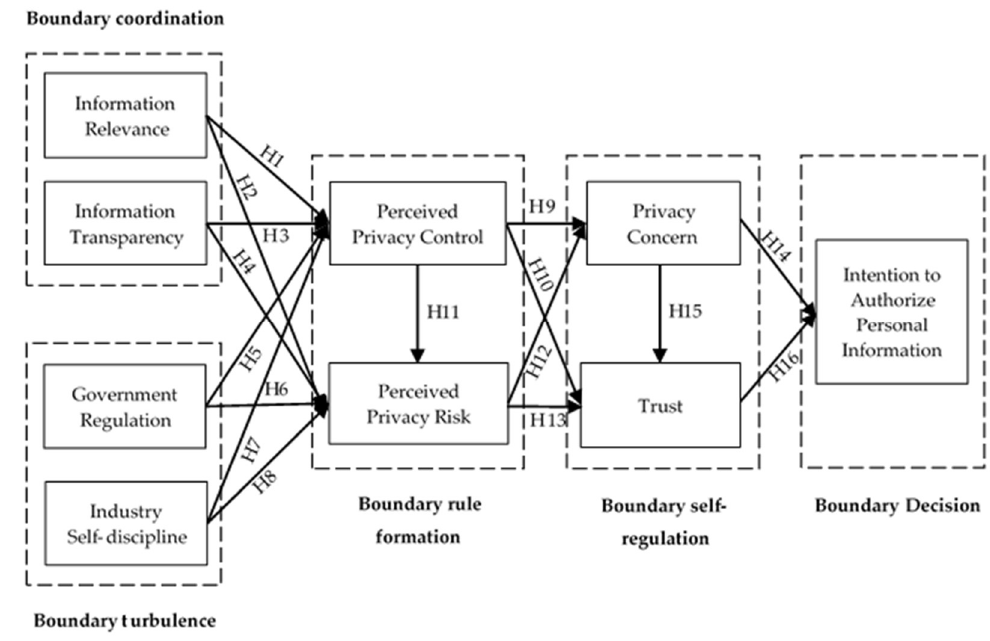
Figure 1. Conceptual